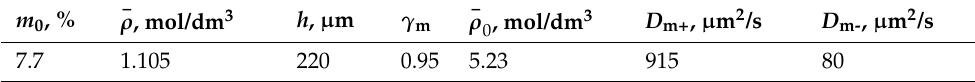
Table 1. Parameters of the MF − 4SC extrusion p.29 membrane in NaCl solution.